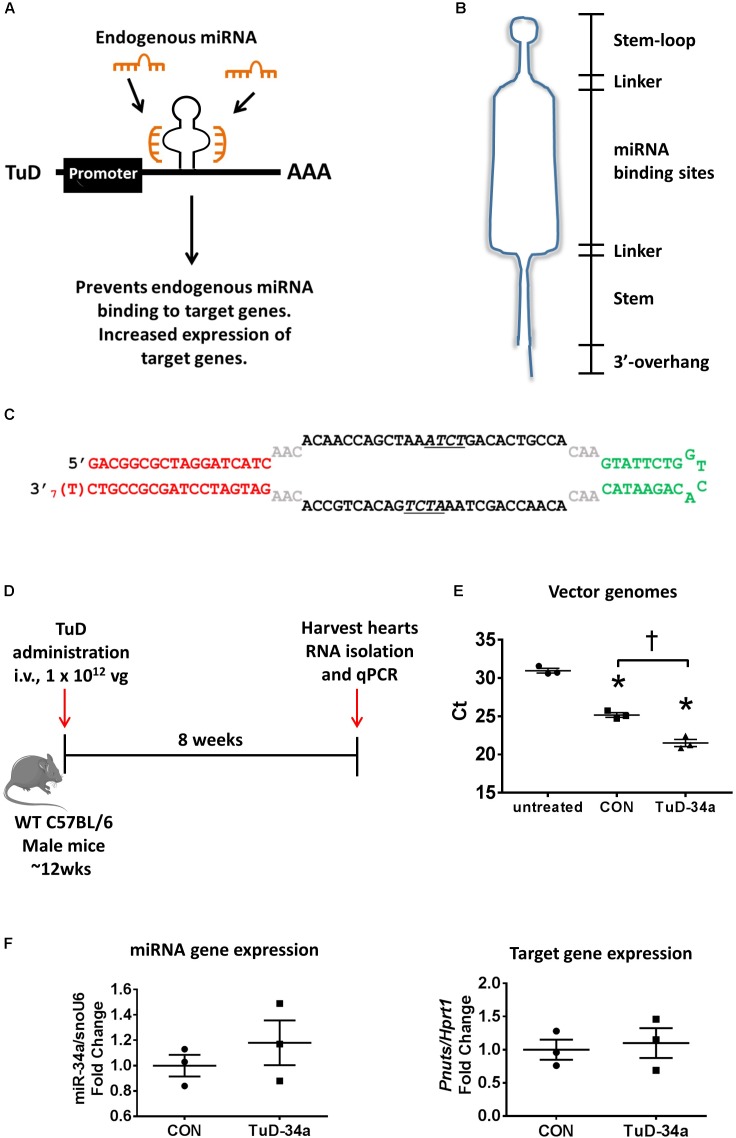
Design and testing of a tough decoy (TuD) targeting miR-34a. (A) A schematic of the TuD miRNA expression cassette design. The TuD acts as a competitive inhibitor and will bind endogenous miRNAs preventing them binding to target genes, resulting in increased expression of target genes. (B) TuD design. (C) Sequence of the TuD-miR-34a. (D) Experimental timeline. (E) Detection of vector genomes in untreated, control and TuD-34a treated hearts. Lower Ct (cycle threshold) indicates higher expression. N = 3/group. Data mean ± SEM. One way ANOVA with Fisher’s post hoc test. ∗P < 0.05 vs. untreated. †P < 0.05. (F) Expression of miR-34a (left) and Pnuts (right) by qPCR in control and TuD-34a treated hearts. Data mean ± SEM. N = 3/group. Abbreviations: AAA, poly A tail; i.v., intravenous; TuD, tough decoy; vg, vector genomes.